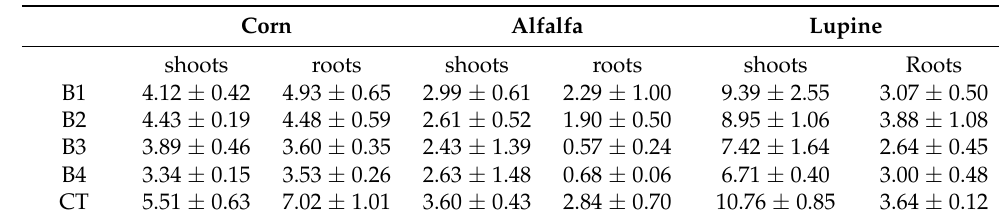
Table 5. Fresh weight (g) of plants (shoots and roots) grown on different soils. The reported value is the mean of the replicates with the standard deviations. Corn Alfalfa Lupine roots shoots roots shoots Roots